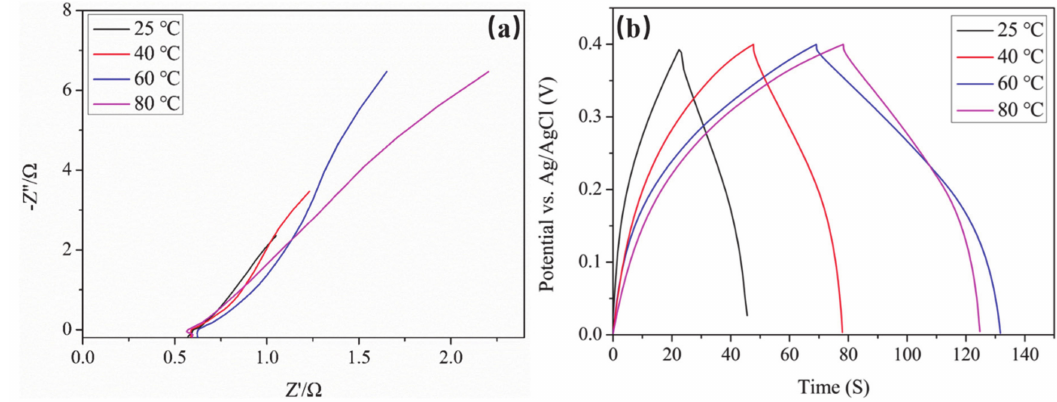
Figure 7. EIS of the CuO / Cu foam prepared with di ff erent anodizing temperature at 20 mA cm − 2 current density ( a ) and GCD curves ( b